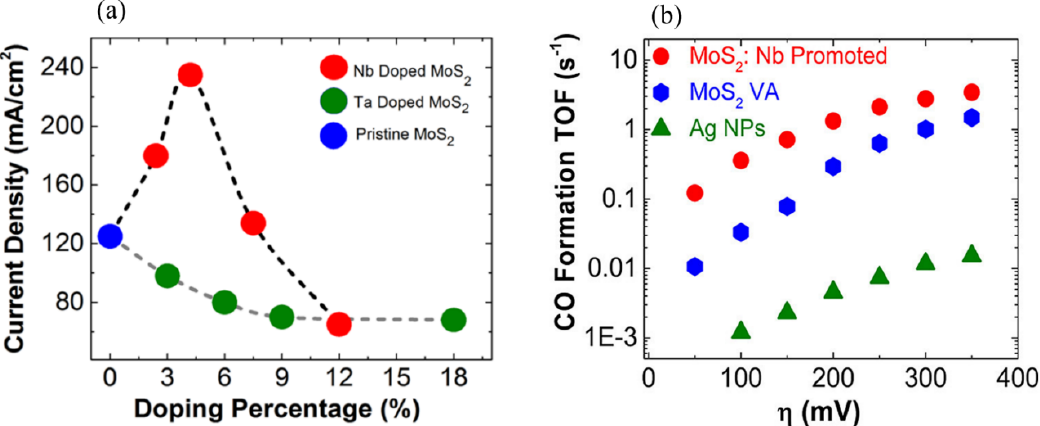
Figure 5. ( a ) Current density as a function of dopant percentage for Nb doped and Ta doped MoS 2 samples. ( b ) Calculated CO formation TOF at different applied overpotentials for 0.5% Nb-doped MoS 2 , pristine VA-MoS 2 and Ag nanoparticles. Reprinted from [87], Copyright (2017), with permission from American Chemical Society.